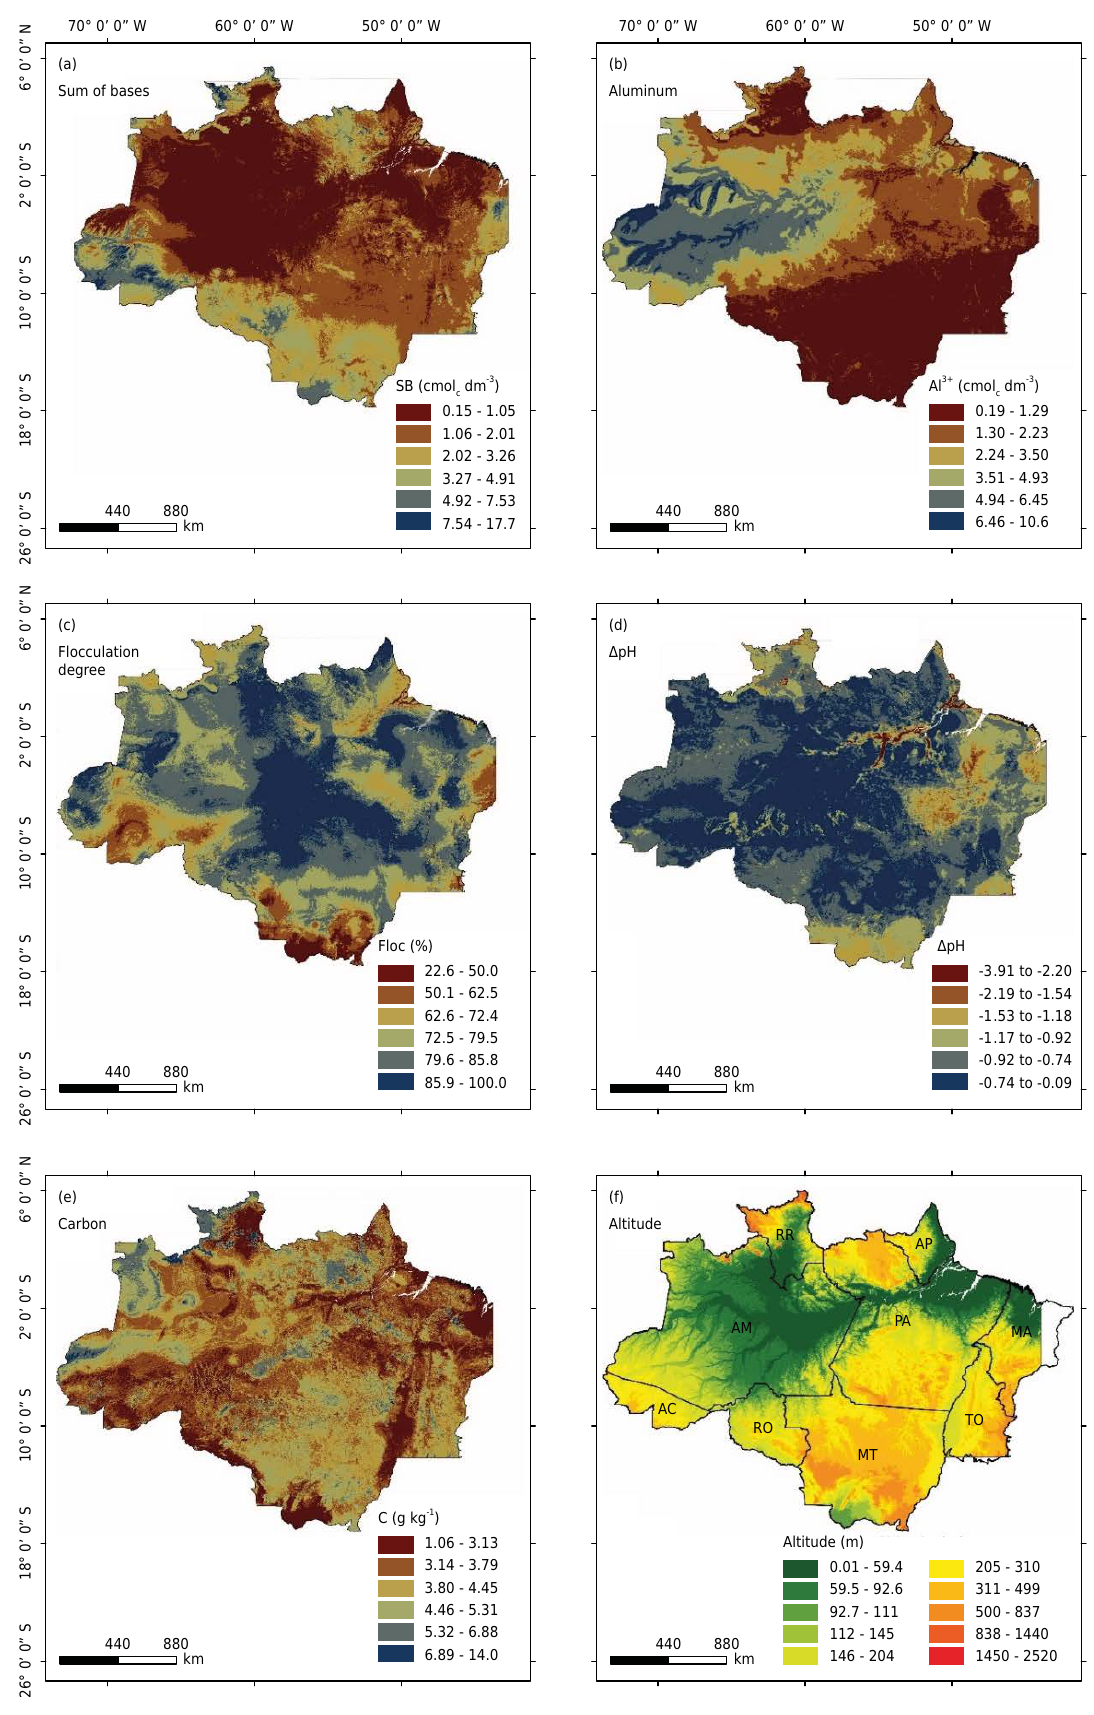
Figure 4. Thematic maps obtained by machine learning of soil attributes: sum of bases (a), aluminum (b), degree of flocculation (c), ∆pH (d), carbon (e). Map of altitude and location of the states for correlation of the attributes of soils mapped with geographical location and altitude